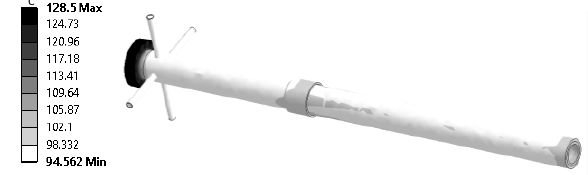
Fig. 4. Temperature distribution of the outer surface of the conceptual equatorial launcher waveguide. The most significant heating occurs at the non-cooled flange at the non-vacuum side, where the temperature rise is around 33  C. The water inlet temperature is 94.5  C.